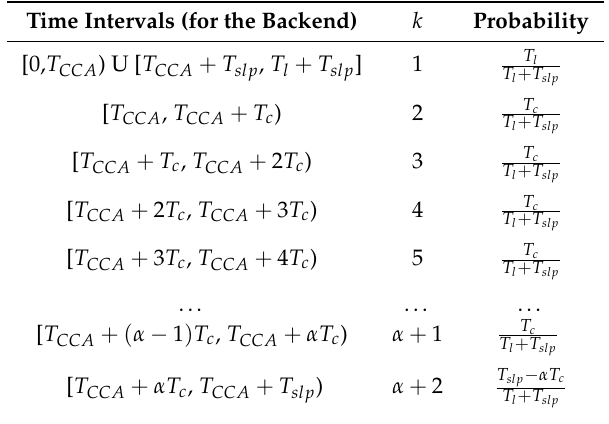
Table 1. Characterization of the number of tries ( k ) in the process of sending a packet. Time Intervals (for the Backend)